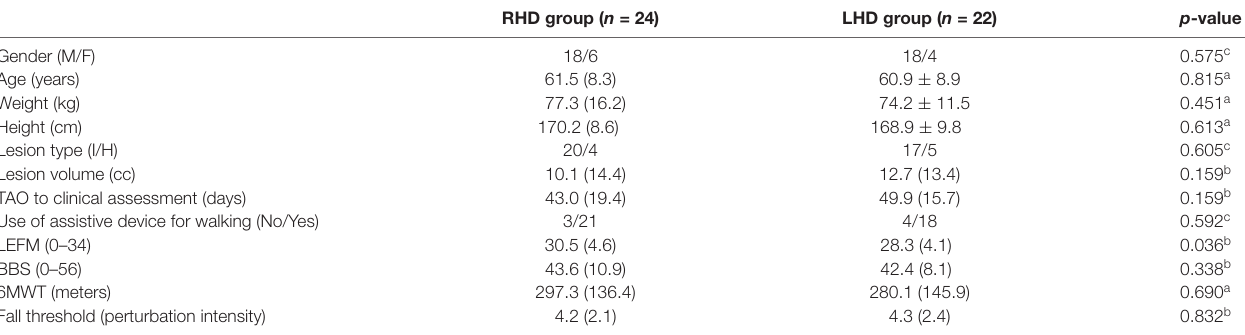
TABLE 2 | Demographic and clinical characteristics of